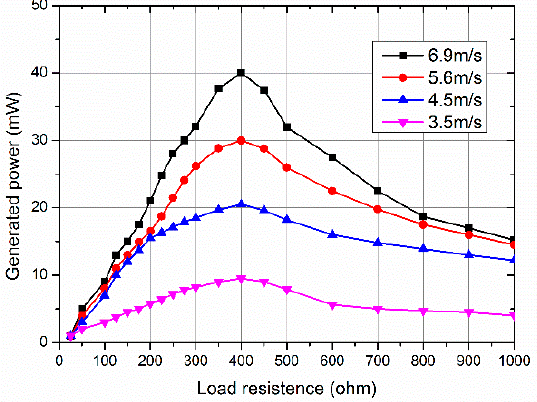
Figure 6. The variation of Wind Turbine Generator (WTG) output power under different wind speed V.S. Its subsequent workload.